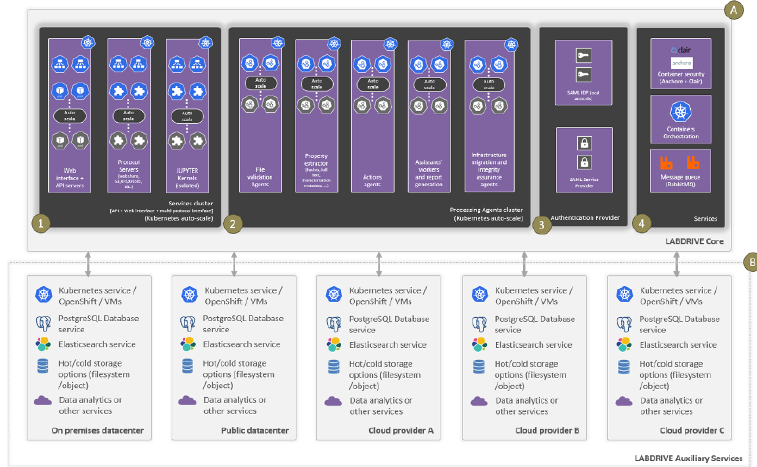
Fig. 7. Prototype architecture of the Libnova